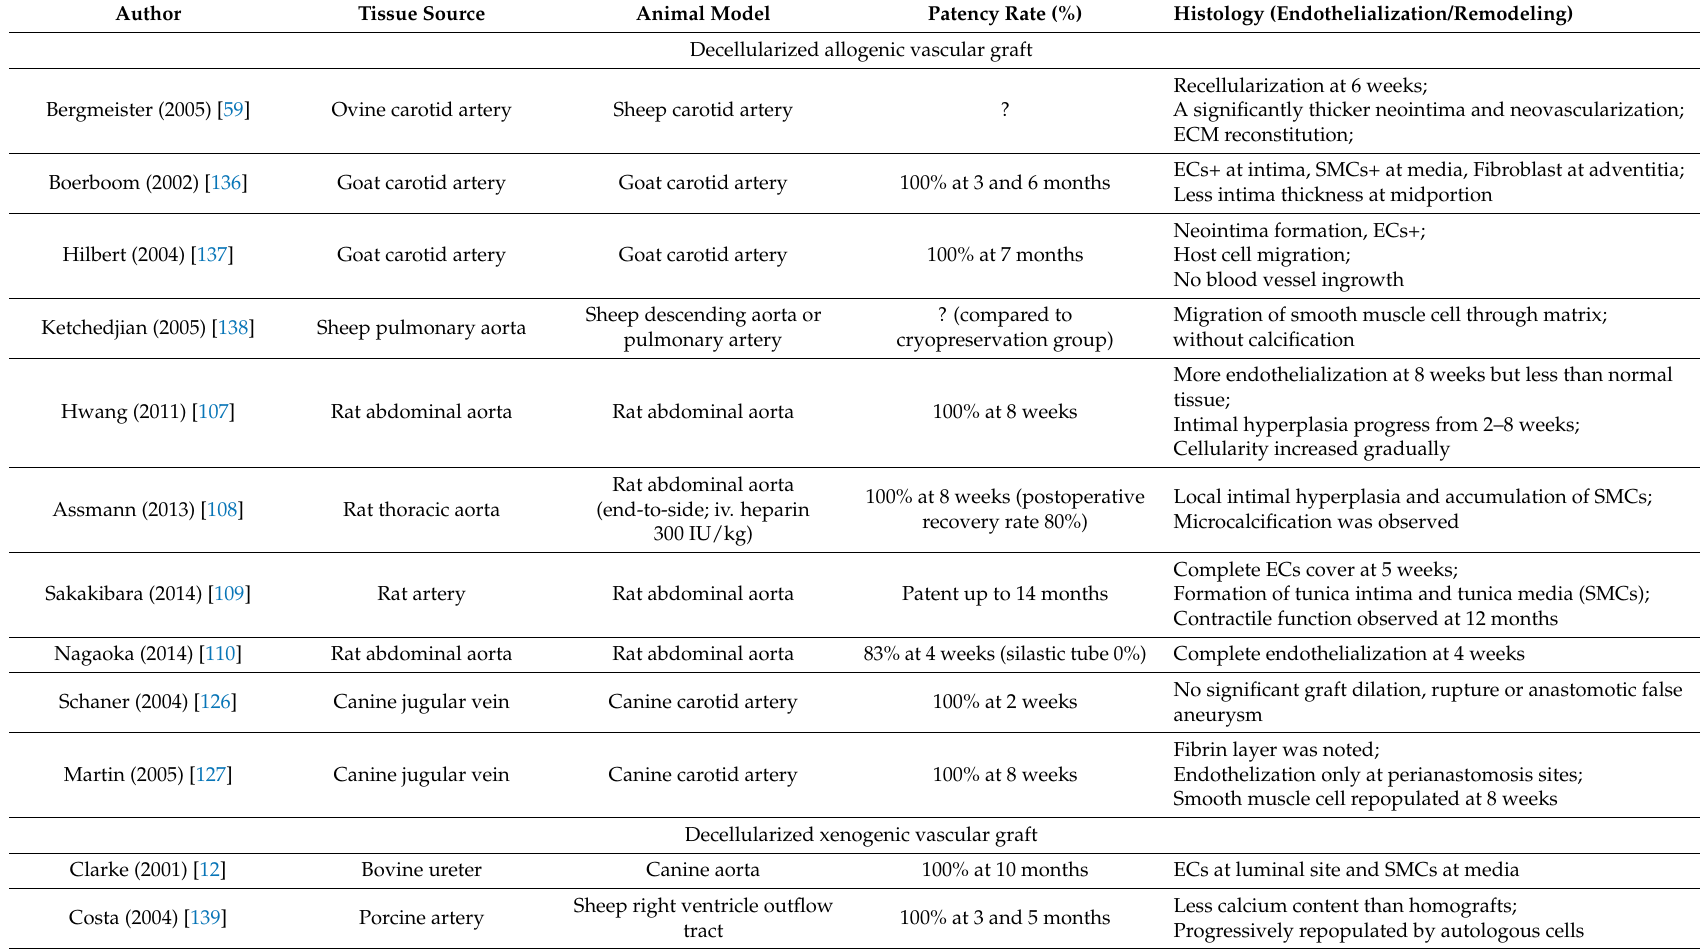
Table 2. Summary of in vivo performance of cell-free decellularized grafts without further treatment since